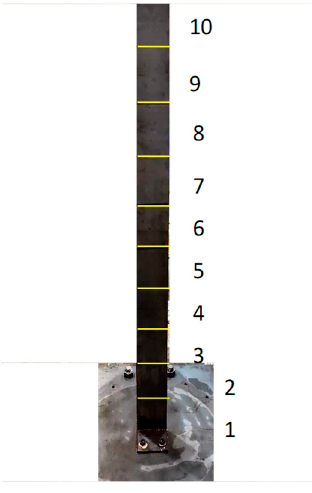
Figure 2. Cantilever beam model.